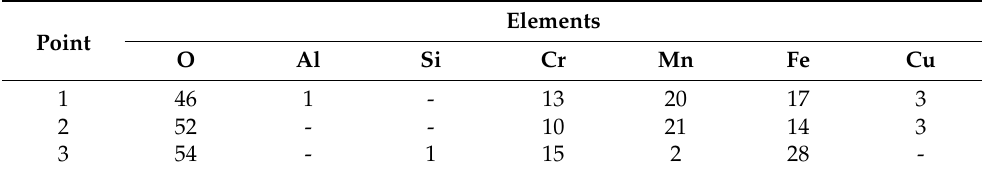
Table 3. Results of EDS analyses (at.%) performed at points of Figure 6.